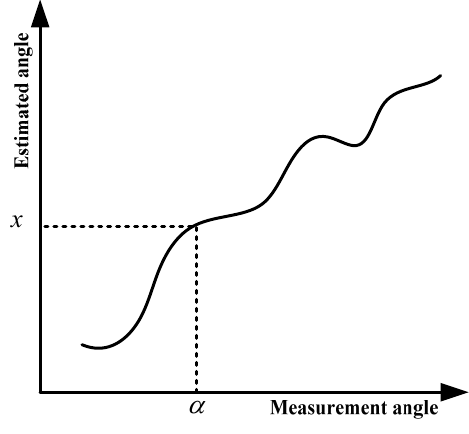
Figure 12. Relationship between the measurement angle and estimated angle.